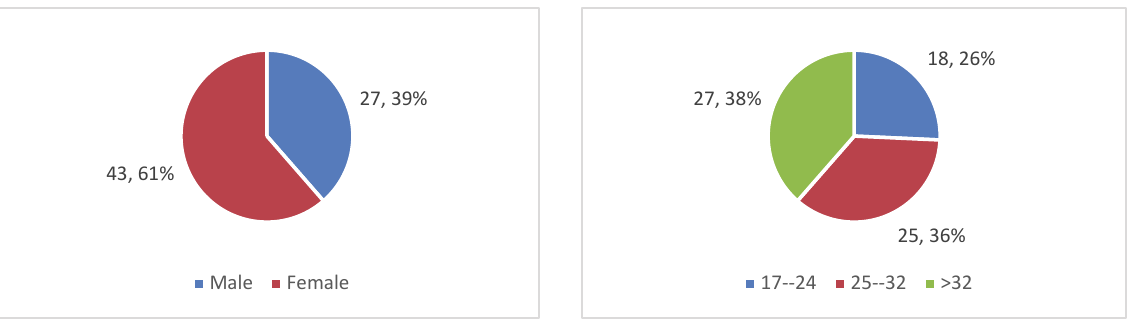
Fig. 2. Characteristics of the respondents Source: Research Data Processing Results,